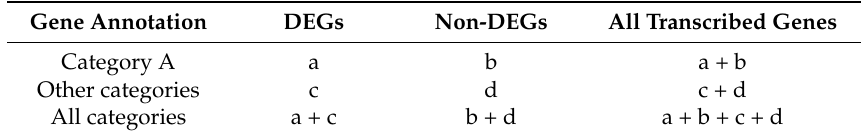
Table 4. 2 × 2 contingency table for Fisher’s exact